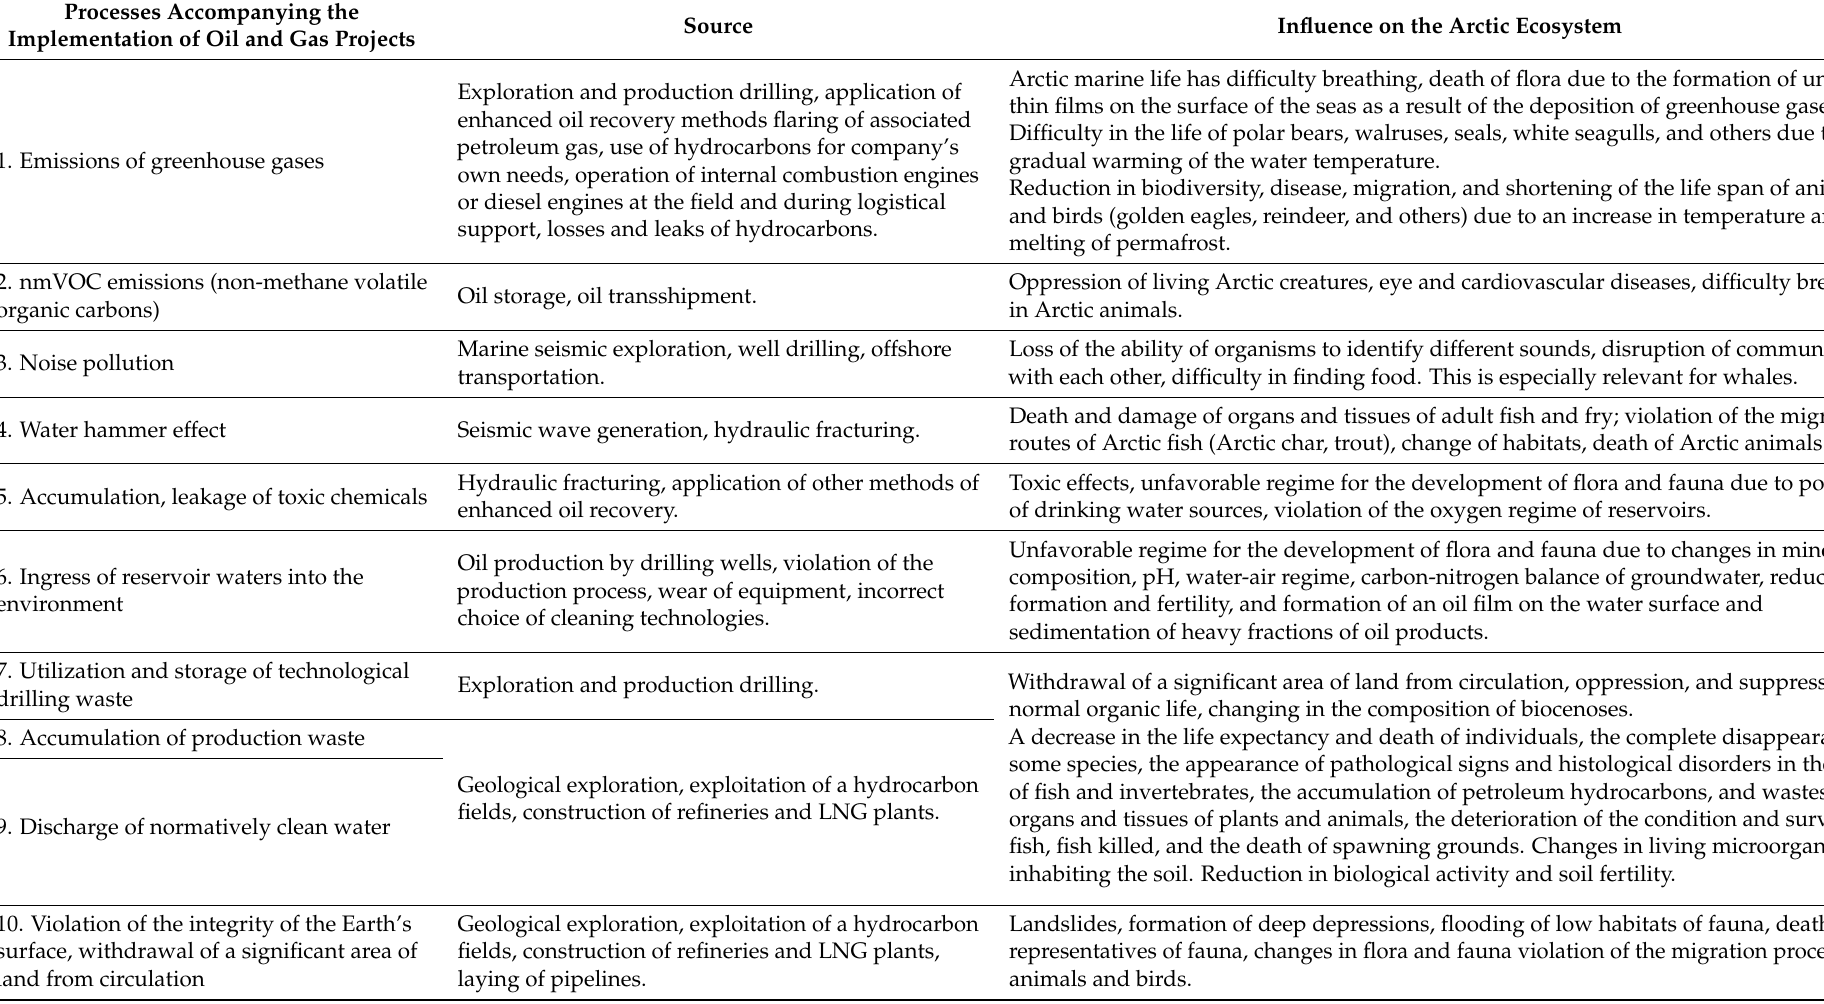
Table 4. Register of processes accompanying the implementation of oil and gas projects in the Arctic (created by the authors, based on [11,12,18,25,27,35,38–55,74–78]). Processes Accompanying